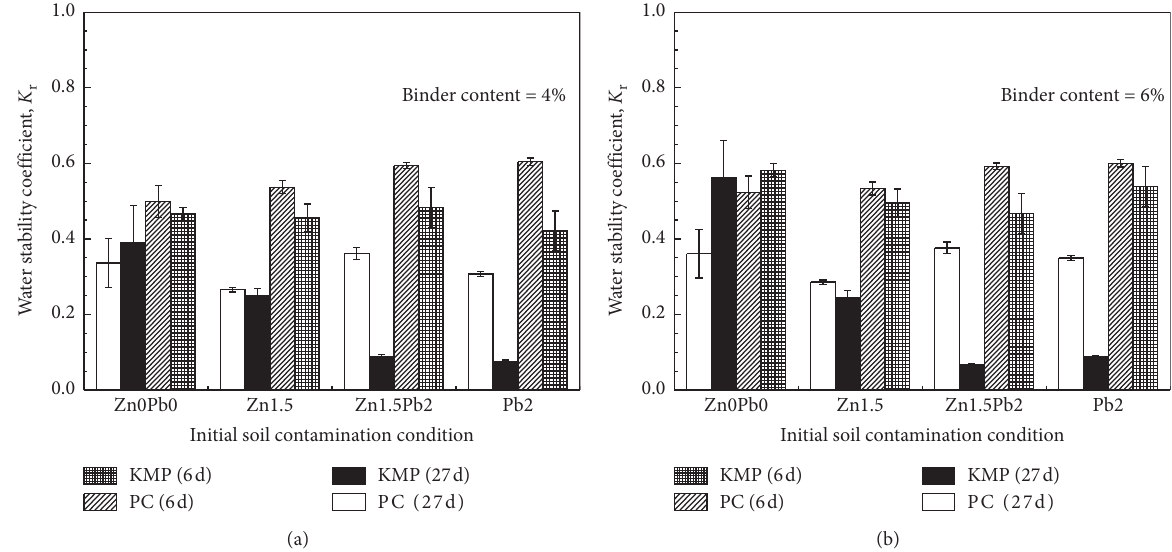
Figure 5: Variations in the water stability coefficient ( K r ) with the initial soil contamination conditions for the stabilized soils cured for 6 and 27d: (a) 4% binder and (b) 6%